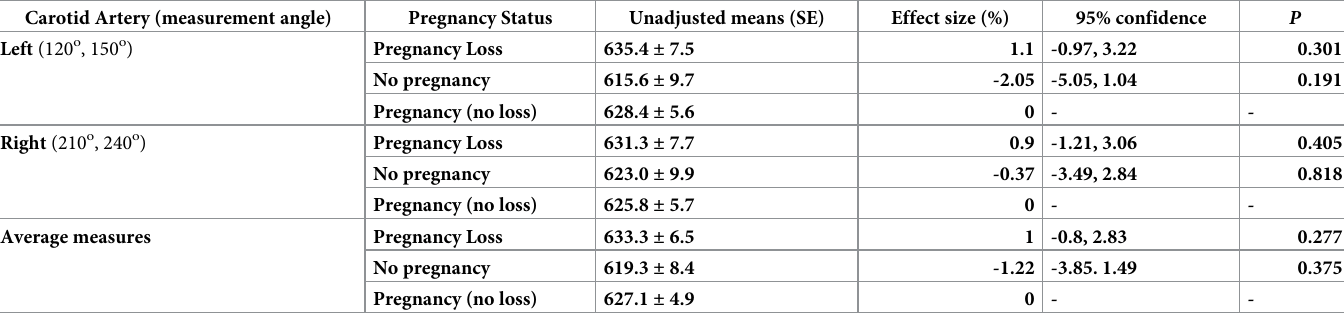
Table 4. Unadjusted CIMT measurements. Carotid Artery (measurement angle)